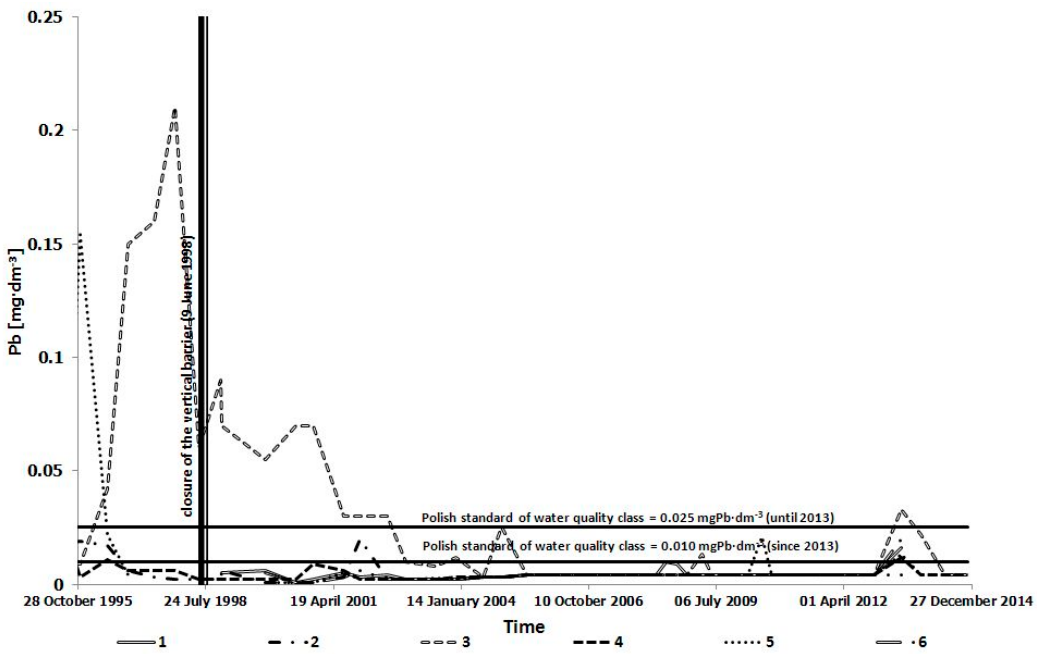
Figure 7. Changes of lead concentration in groundwater on MSW Łubna Landfill surroundings during monitoring period 1994–2014.